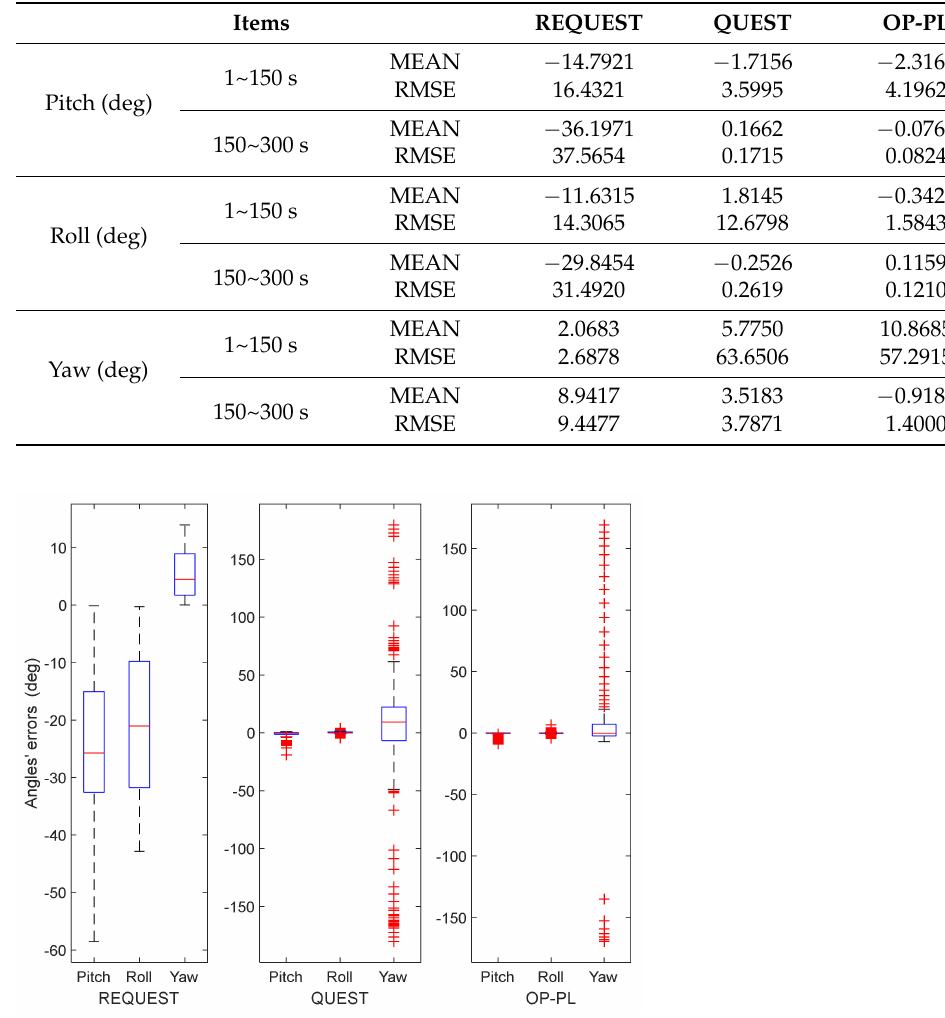
Figure 11. Box plot of angle